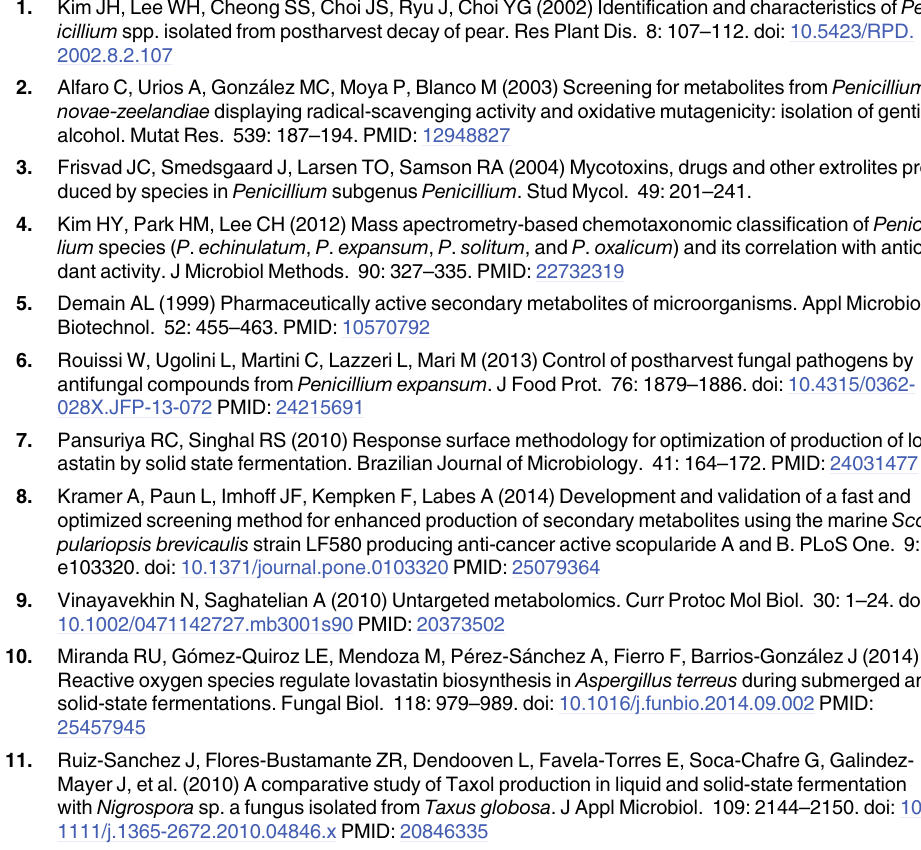
S2 Fig. Differentially expressed ROS/defense-related genes in SSF and SmF. Abundance val- ues (log SSF/SmF) and transcripts with significant variations (log 2 greater than 1) are shown. S3 Fig. Biosynthesis pathway of andrastin (A) and azaphilones (B)